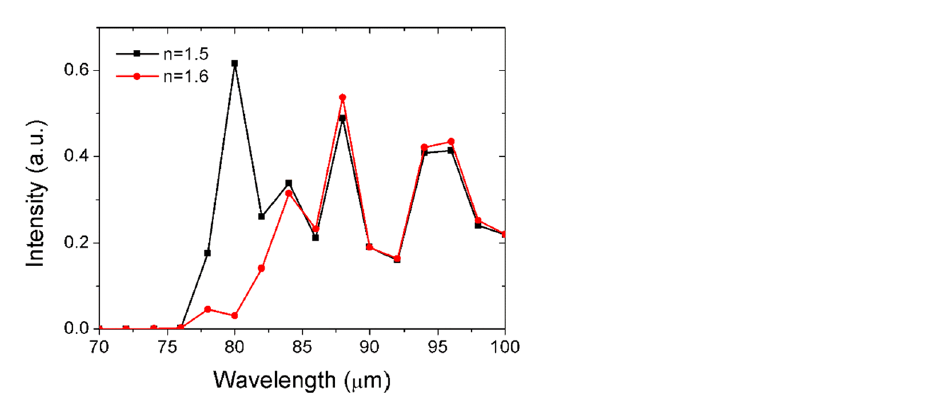
Figure 6. The transmission spectrum of the single groove (Δ d = 40 μm) with different refractive index: n = 1.5 (square dotted black line), n = 1.6 (circle dotted red